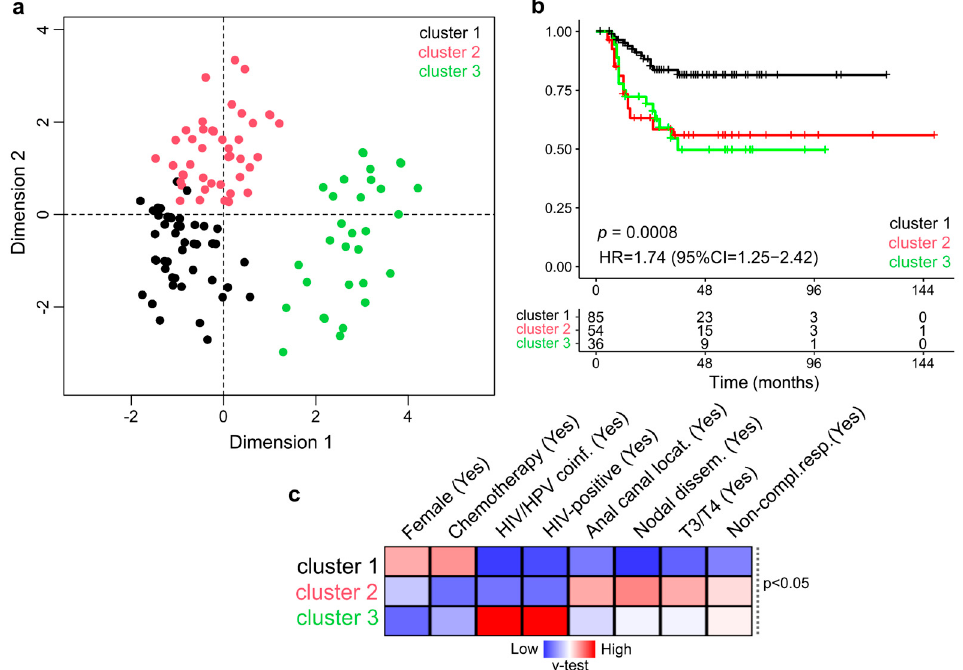
Figure 2. Multivariate and unsupervised analysis of clinicopathological features of NM-ASCC patients. ( a ) Multidimensional scaling plot showing the Euclidean distance of each sample from each other determined by their similarities for the included variables. The 176 patients were segregated into three classes: Cluster 1 (black), Cluster 2 (red), and Cluster 3 (green). ( b ) Univariate Kaplan-Meier survival analysis according to the assigned cluster. Survival analyses revealed that Cluster 1 was particularly associated with longer DFS compared with Clusters 2 and 3 ( p = 0.0008). ( c ) Heatmap of the statistically significant variables ( p < 0.05) that contributed to cluster discrimination based on positive (red) and negative (blue) v-test values.